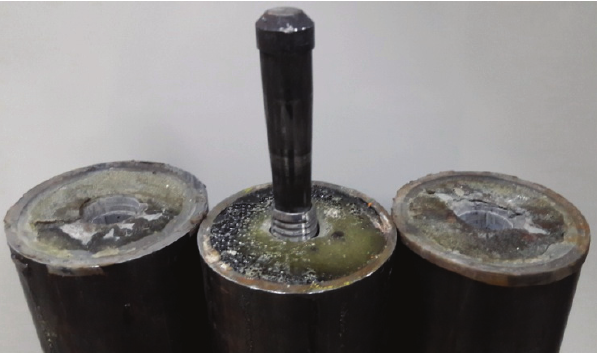
Fig. 8. Cylinders filled with rock cores (photo by K. Skrzypkowski)